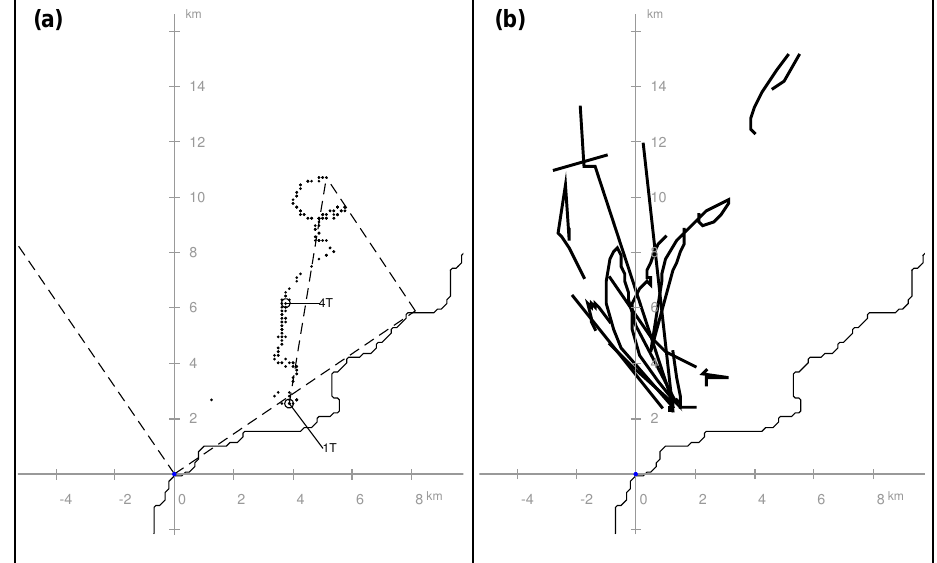
Figure 10. The trajectories of the bulge centre for the idealized simulation (a) and the realistic simulation (b) from 24 March 2007 05:00 to 5 April 2007 00:00. Each dot shows the location of the bulge centre at hourly intervals. Dashed lines show the normal and tangent to the coastline, the distance of the bulge centre from the location at 1 T up to the end of the simulation, and the distance of the bulge centre at the end of the simulation to the coast in the direction of the normal to the coast. 1 T and 4 T show the location of the bulge centre after one and four rotation periods of the earth starting from 24 March 2007 05:00 (a) . Discontinuities in the bulge trajectories for the realistic model simulation exist because the bulge centre was defined only if anti-cyclonic circulation with closed streamlines was present (b)